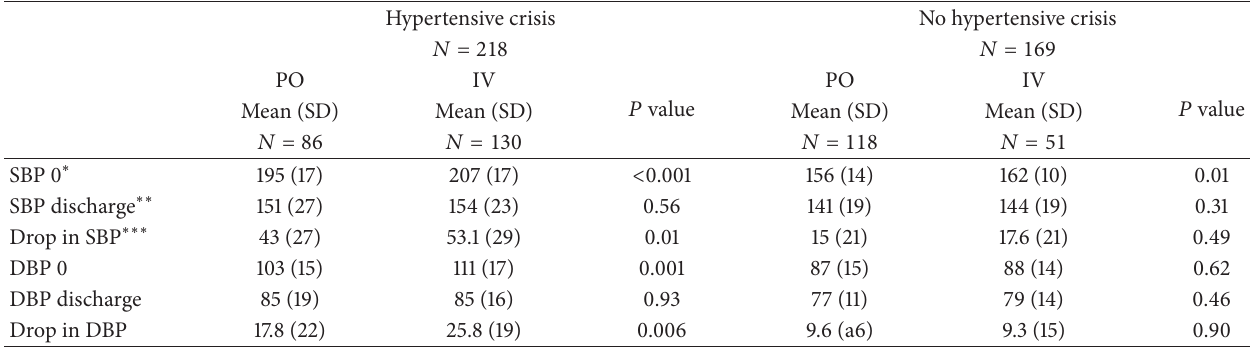
Table 2: Comparison of blood pressure in patients with and without hypertensive crisis on intravenous and per oral medications. Hypertensive crisis